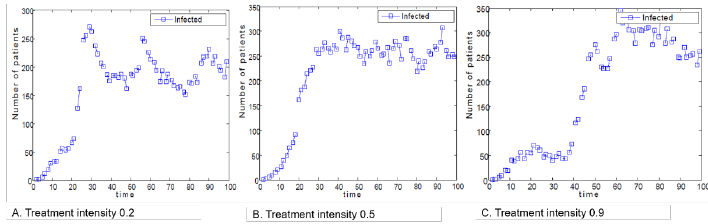
Fig. 4 The impact of education intensity on